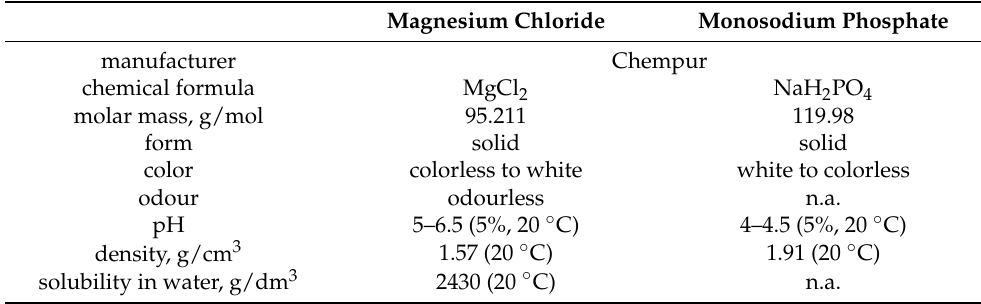
Table 2. Characterization of the chemical reagents used in struvite precipitation